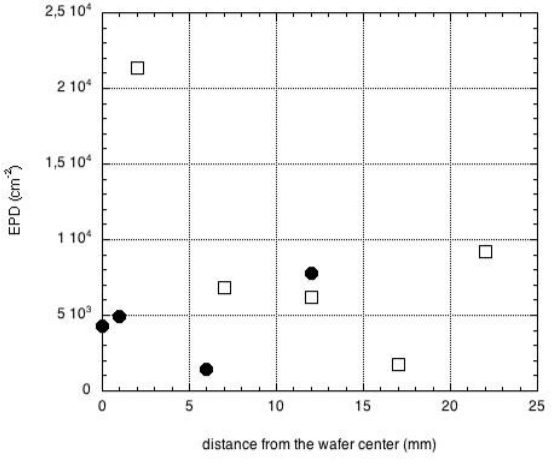
Figure 14. EPD in 1-inch (plain dots) and 2-inch (squares) CdZnTe crystals grown by the boron oxide vertical Bridgman